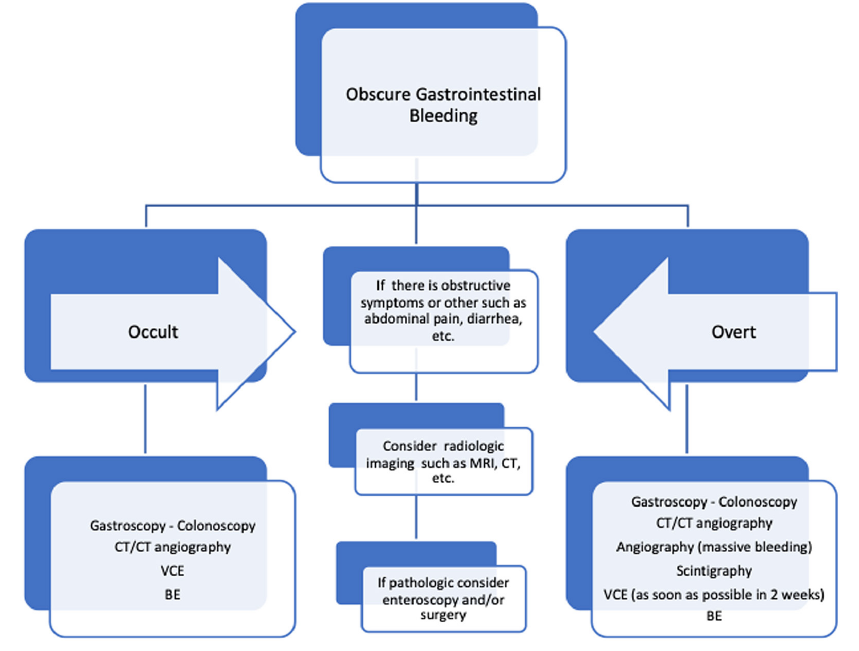
Figure 2. Management of